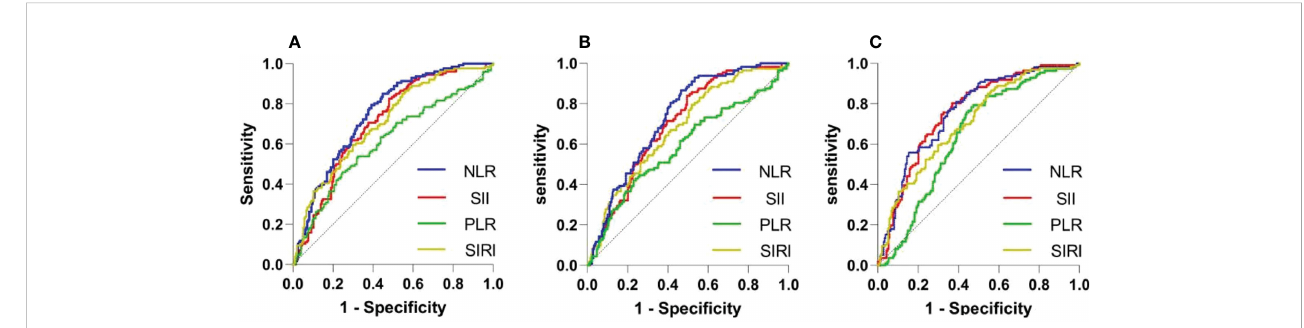
FIGURE 2 ROC curves of the NLR, PLR SII and SIRI for predicting SAP occurrence (A) , ICU admission (B) and good outcomes at discharge (C) . ROC, receiver operating characteristic; NLR, neutrophil-to-lymphocyte ratio; SII, systemic immune-in fl ammation index; PLR, platelet-to-lymphocyte ratio; SIRI, systemic in fl ammation response index; SAP, stroke-associated pneumonia; ICU, intensive care